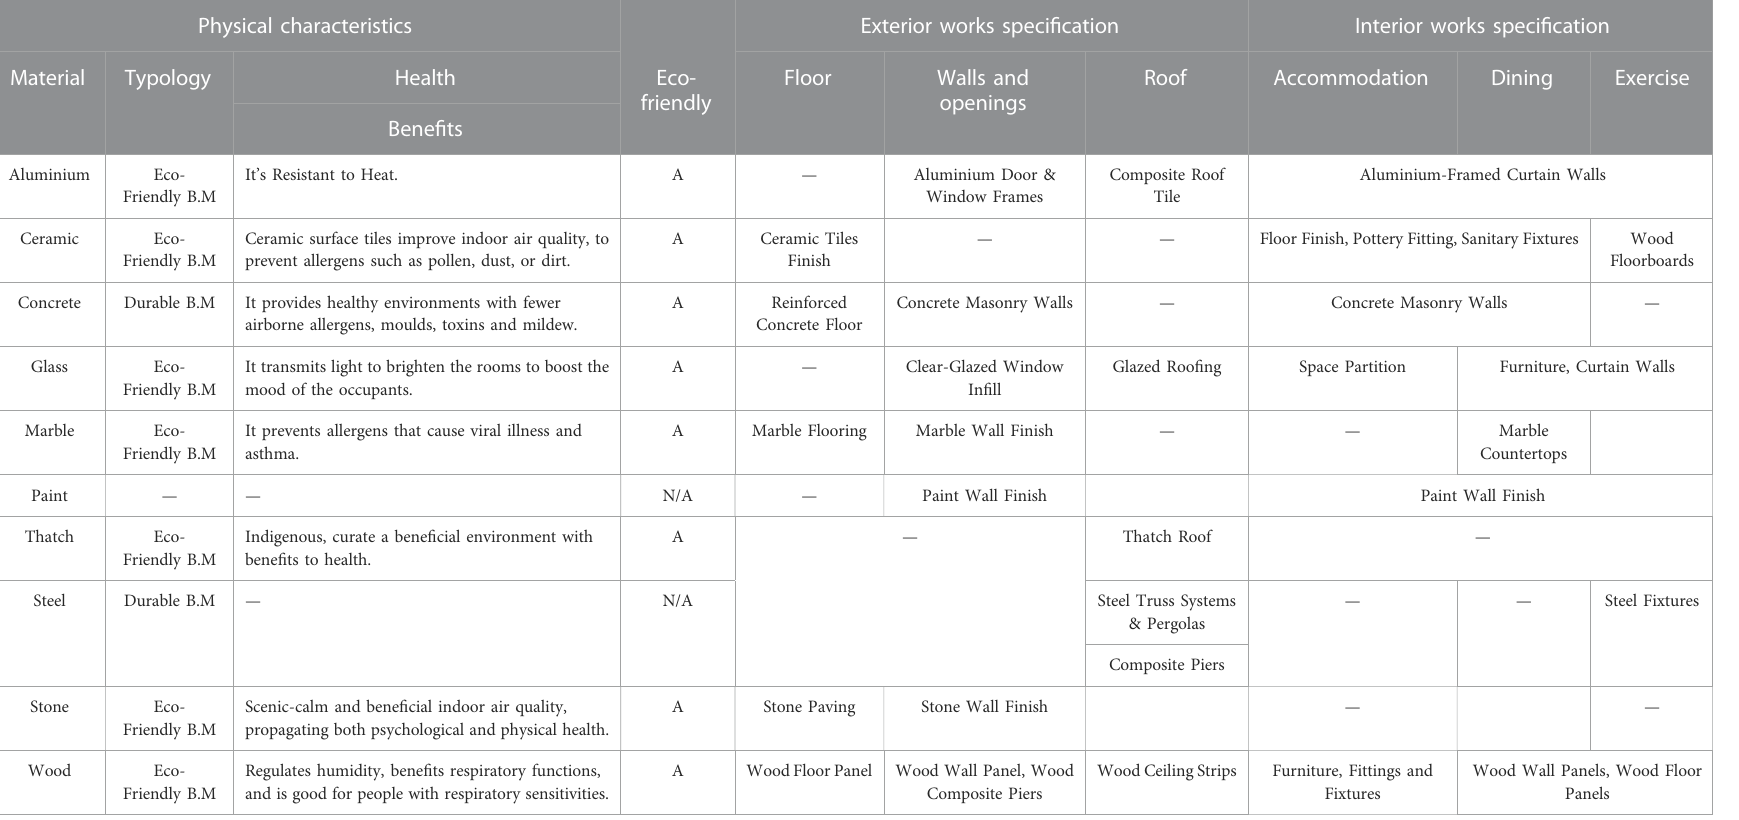
TABLE 5 Atmantan Wellness Centre (Maharashtra,